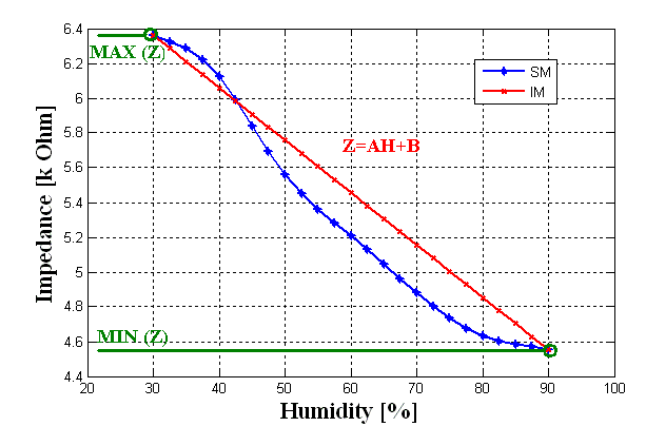
Figure 3. Ideal model output for sample 3 at T = 25 °C and F = 1 KHz in the humidification state.